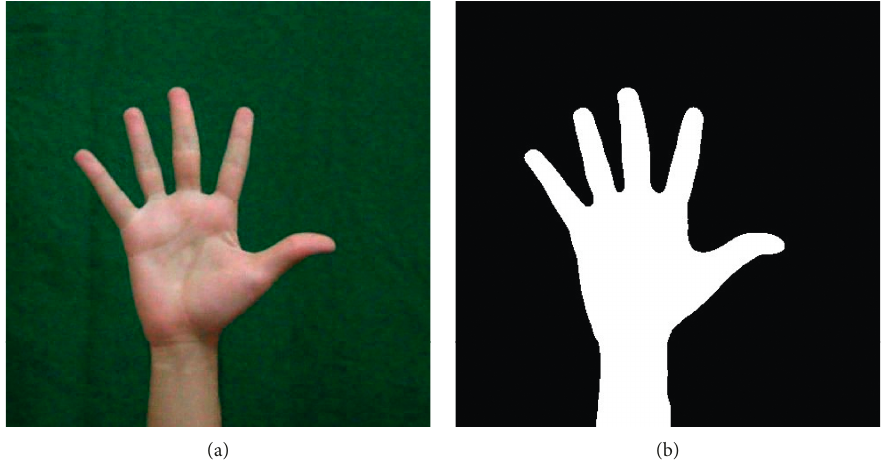
Figure 6: Image (a) and mask (b) used to train the MLP skin color classifier.